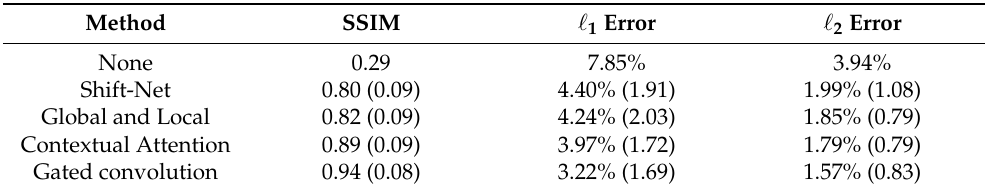
Table 2. Averages and standard deviations in parenthesis of performance metrics (SSIM, (cid:96) 1 and (cid:96) 2 errors) for the image similarity